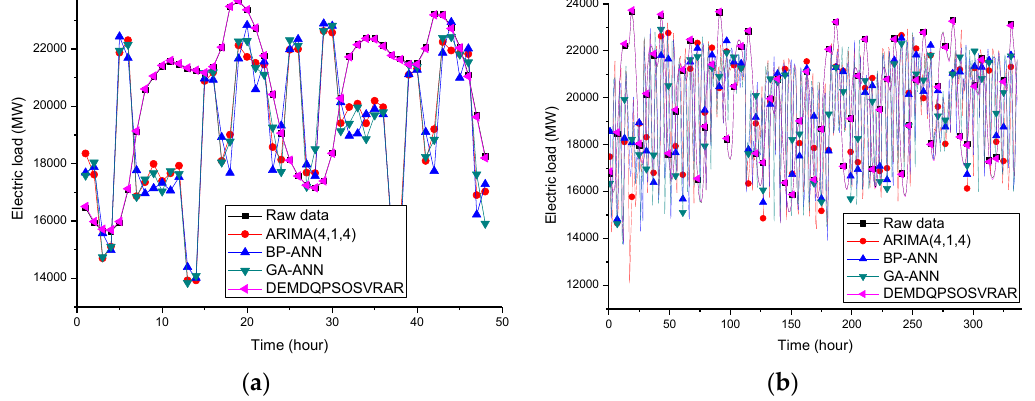
Figure 7. Comparison of the original data and the forecasted electric load by the DEMD-QPSO-SVR-AR Model, the ARIMA model, the BPNN model and the GA-ANN model for: ( a ) the small sample size (One-day ahead prediction from 13 to 14 January 2015 are performed by the models); ( b ) the large sample size (One-week ahead prediction from 2 to15 February 2015 are performed by the models).